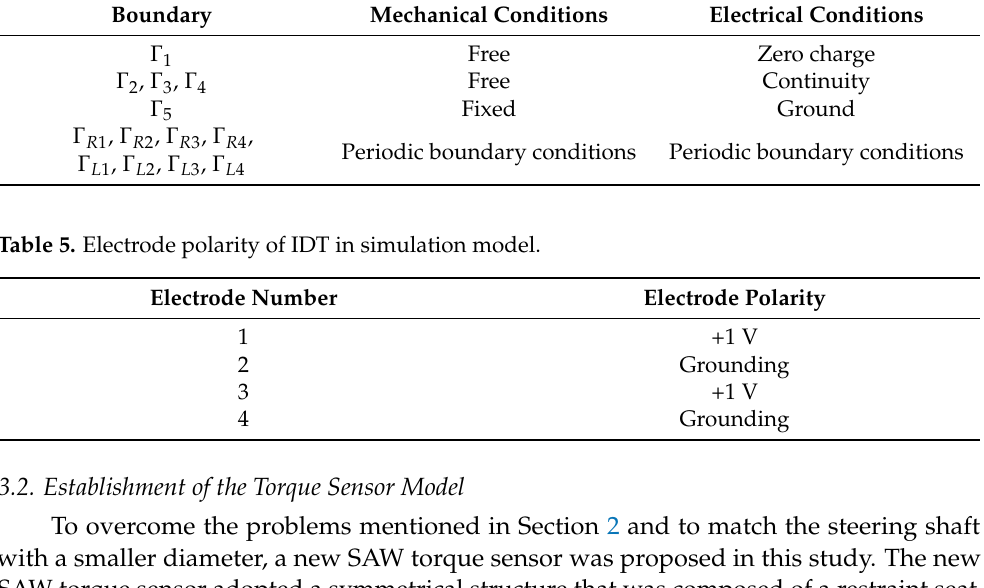
Table 4. Boundary conditions used in simulation models.